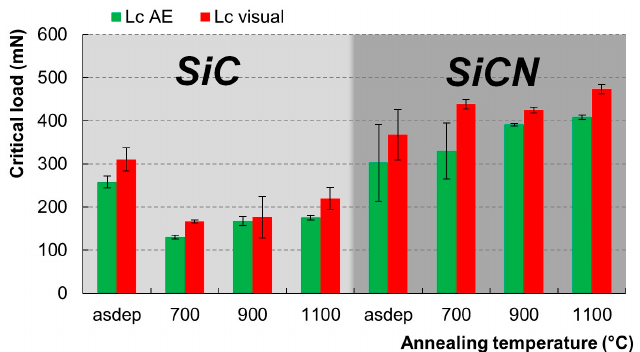
Figure 6. Sum of critical loads of the tested set of samples obtained through the acoustic emission evaluation and the traditional microscopic evaluation of residual scratch. Results show that AE method detected initial failure sooner in all cases.